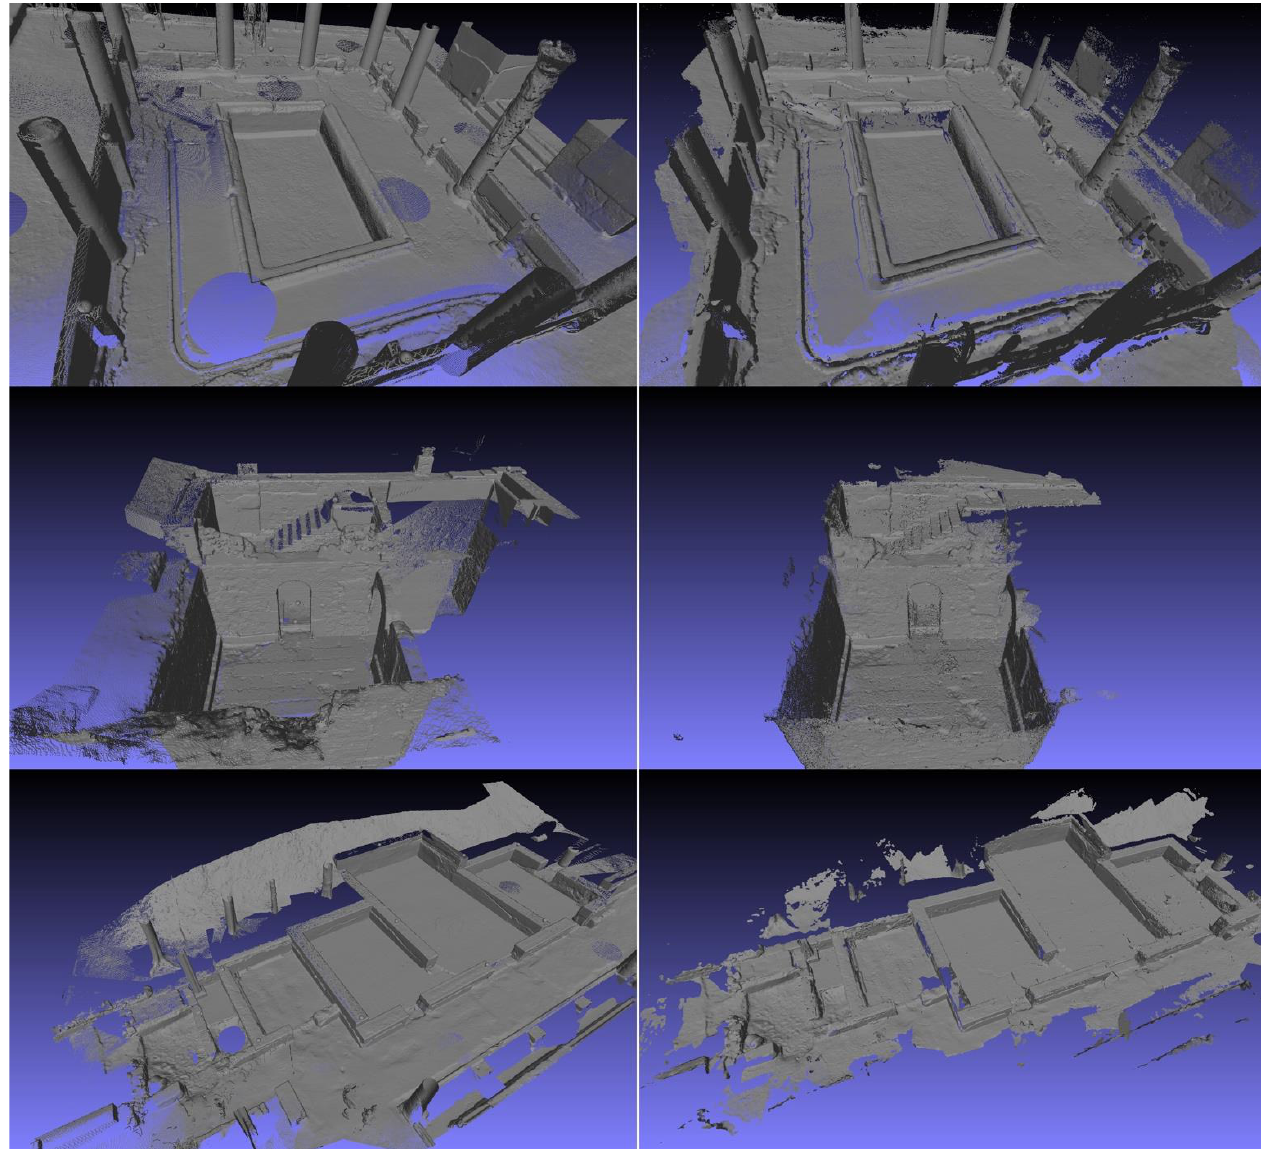
Figure 5. Visual comparison between 3D models without texture generated with the Faro Focus 3D X330 laser scanner (Left) and with the proposed system (Right) for areas 1(up), area 2(middle) and area 3